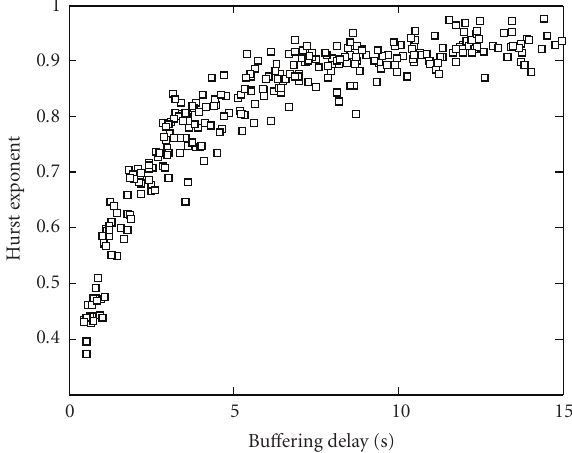
Figure 13: Hurst exponent versus bu ff ering delay in modeled tra ffi cs.